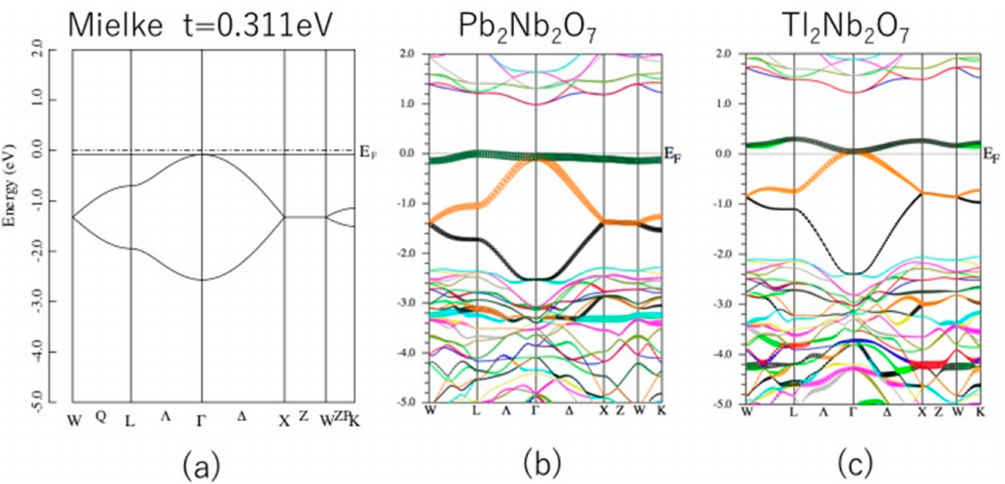
Figure 2. ( a ) Energy band of the Mielke model with t = 0.311 eV. ( b ) Band structure of Pb 2 Nb 2 O 7 and ( c ) Tl 2 Nb 2 O 7 . The spin-orbit interaction is not included. The unit of the vertical axis is